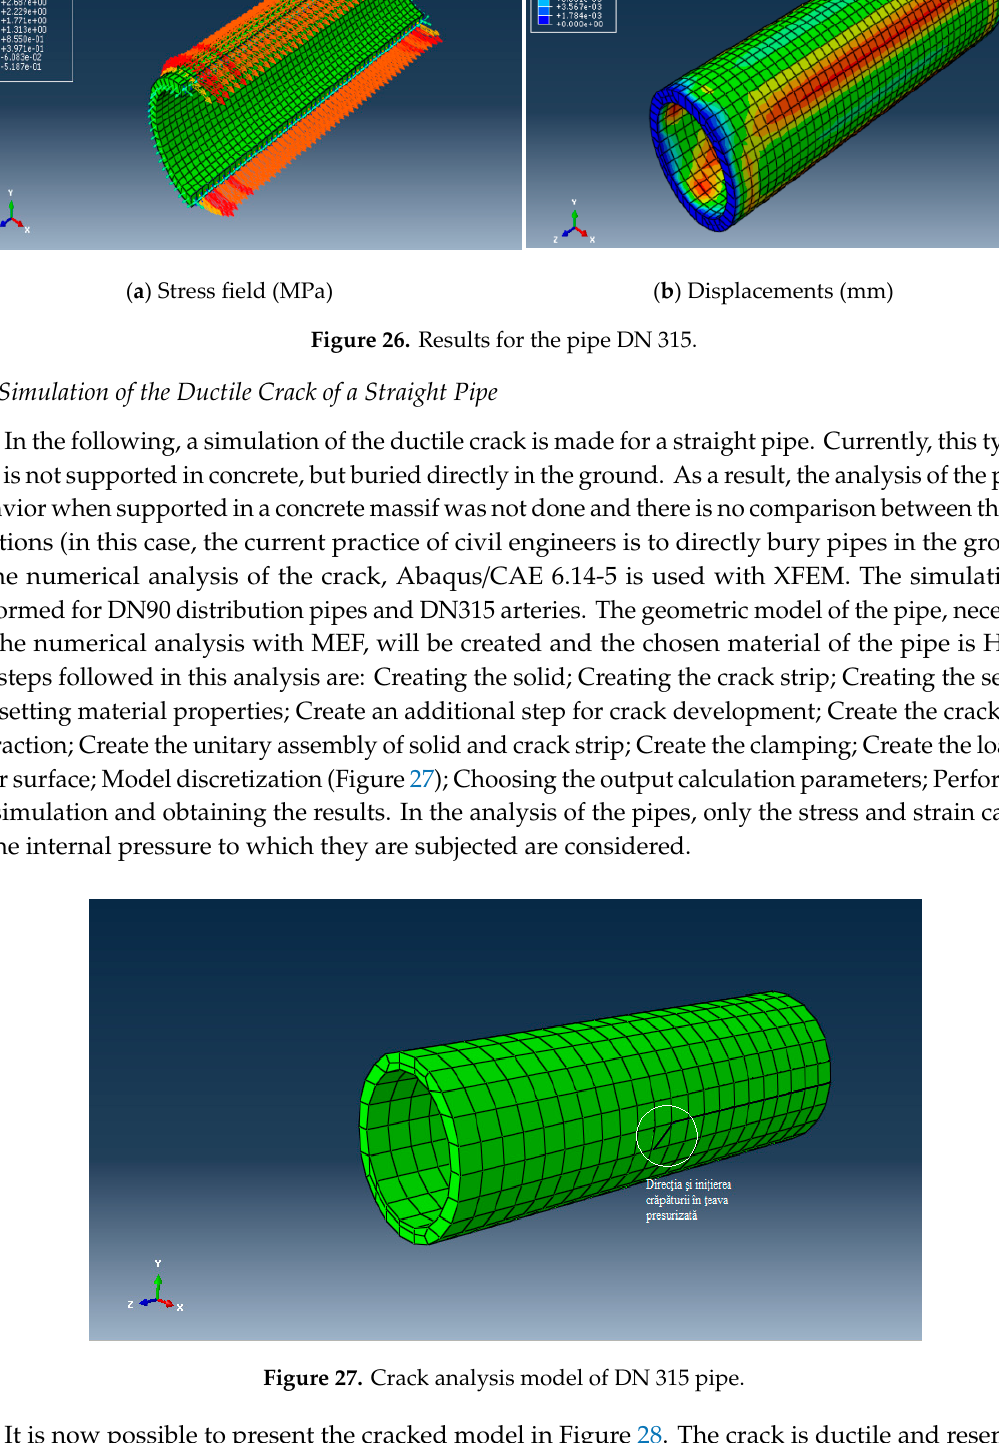
Figure 28. Displacements of the nodes at the crack for the pipes DN315. For the study of the ductile crack of the DN pipes 90 the steps of the analysis are identical to those described previously. The discretized model, with the created interaction of the crack type, is presented in Figure 29a. ( a ) ( b ) Figure 29. ( a ) Crack analysis model of pipe DN 90 and ( b ) Broken model of pipes DN 90.